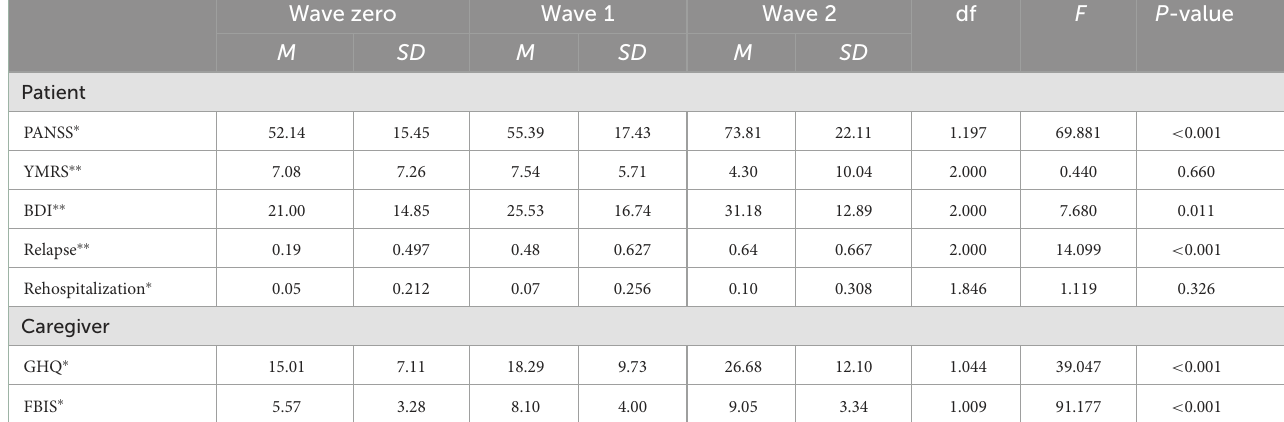
TABLE 2 Repeated measures analysis of variance (ANOVA) for psychopathology of patients and mental health of caregivers.